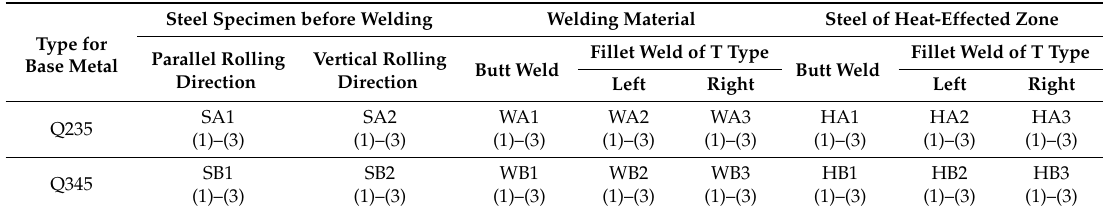
Table 1. Labels of the specimens of low cycle fatigue test.